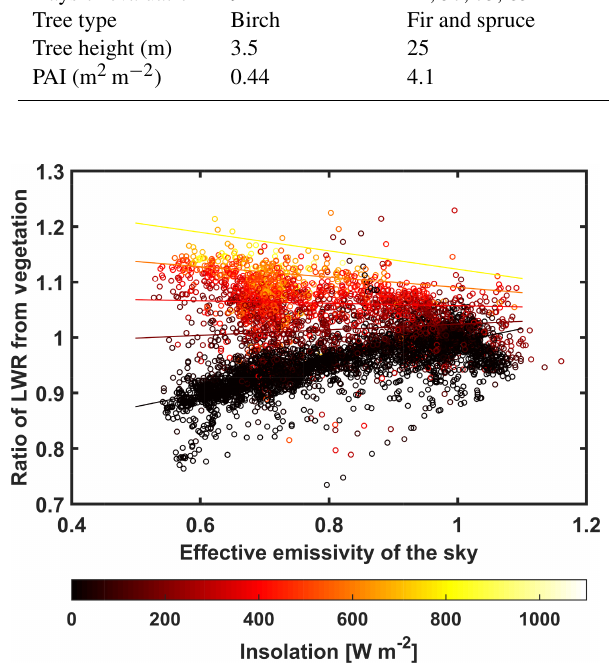
Figure 2. Ratio of longwave radiation emitted from vegetation sim- ulated by CLM4.5 and estimated from forest-stand observations as a function of effective emissivity of the sky (abscissa) and insola- tion (colour) for Alptal (season 2005), Seehornwald (season 2009), Sodankylä, and Cherskiy. Lines represent solutions of Eq. (6) for multiple values of insolation: 0, 200, 400, 600, and 800Wm − 2